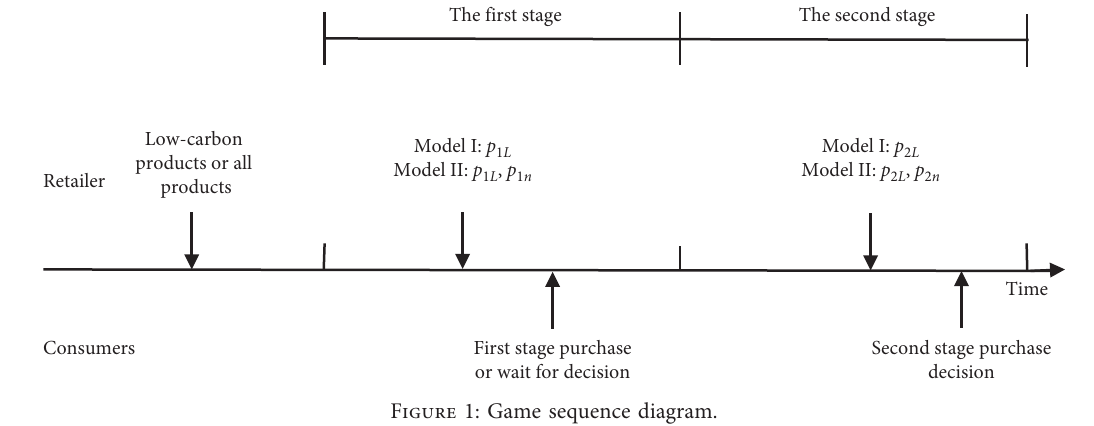
Figure 1: Game sequence diagram.